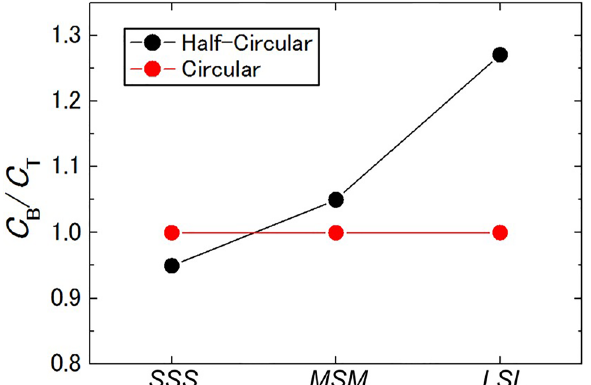
Figure 6. Gate capacitance ratio C B / C T of the central S dot for three dot configurations: SSS , MSM , and LSL ( L = large, M = medium, and S = small). The C B / C T for circular dots (red) and half-circular dots (black) are presented. The C B / C T value of the circular dots was almost constant at 1.0, regardless of the size of the adjacent dots. Conversely, the value changed from 0.95 to a value of 1.27 for half-circular dots with increasing adjacent dot